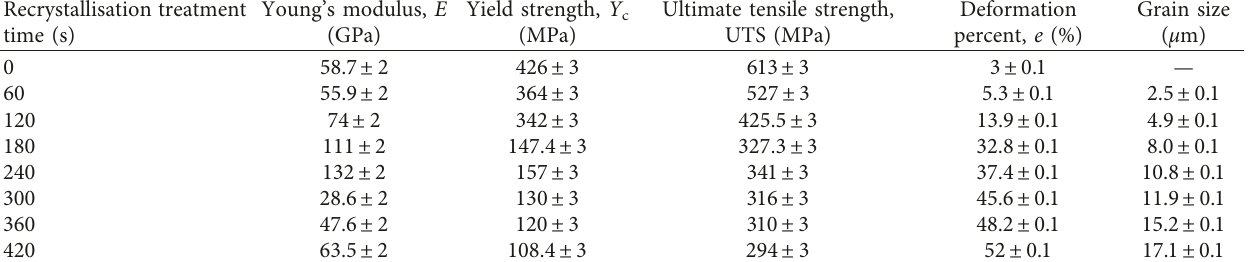
Table 2: Mechanical properties of IF steel as a function of recrystallisation time. Recrystallisation treatment